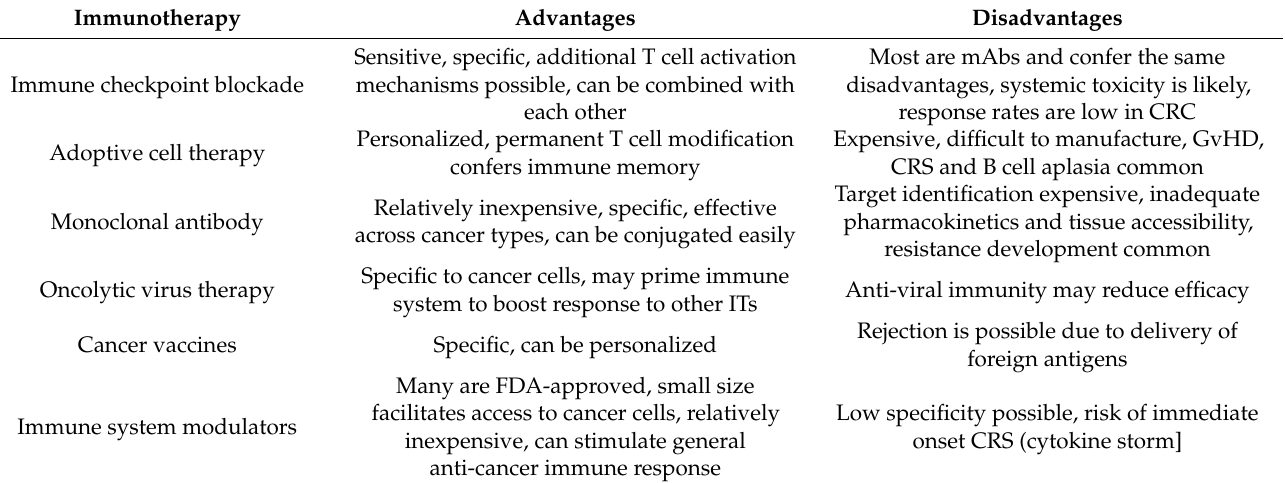
Table 2. Advantages and disadvantages of the IT approaches for treatment of